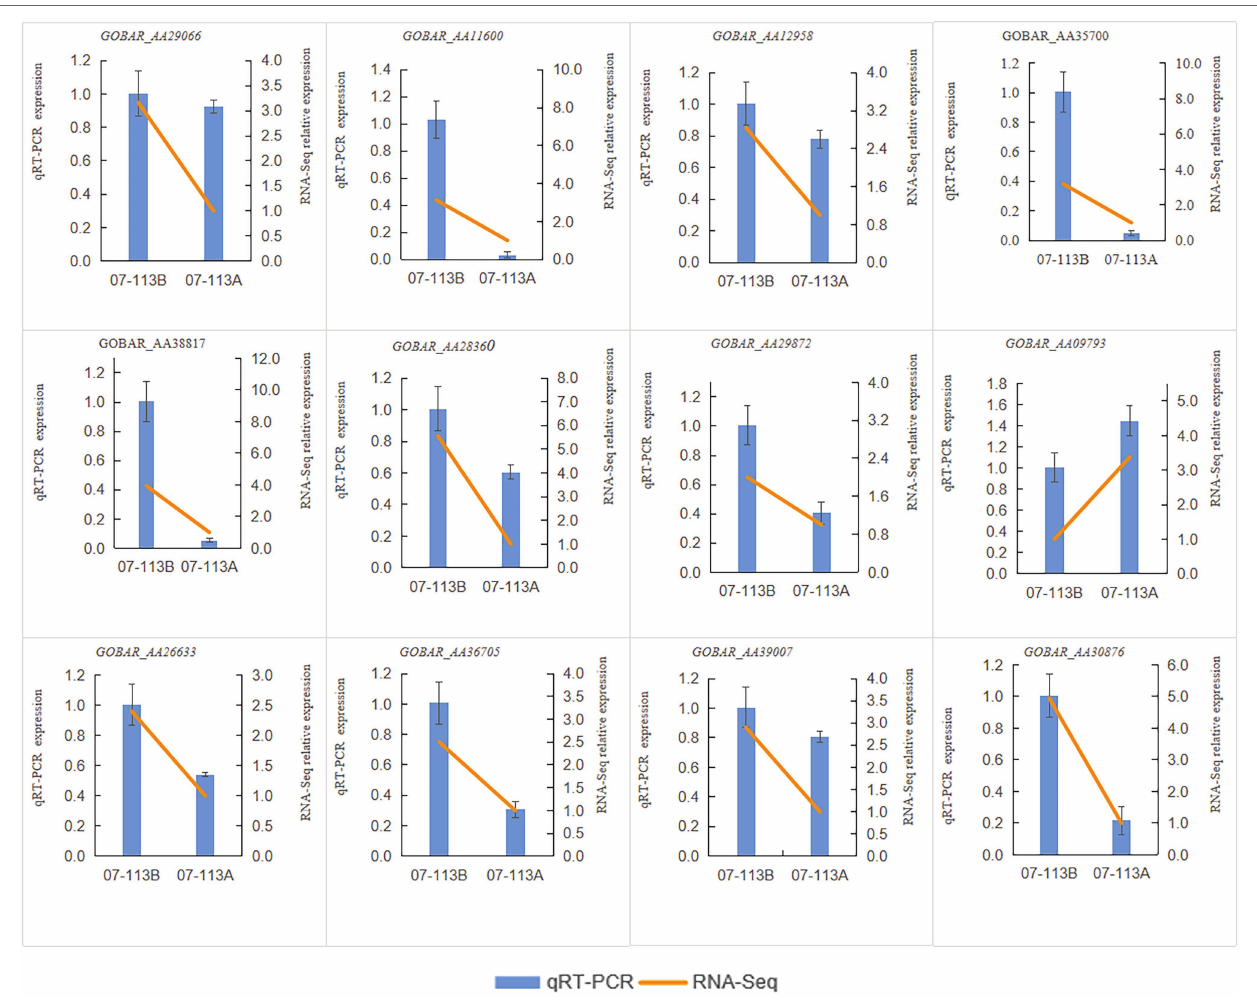
FIGURE 7 | RT-qPCR verification results of 12 genes. The relative expressions levels of the 12 genes were calculated using the 2 - △△ Ct